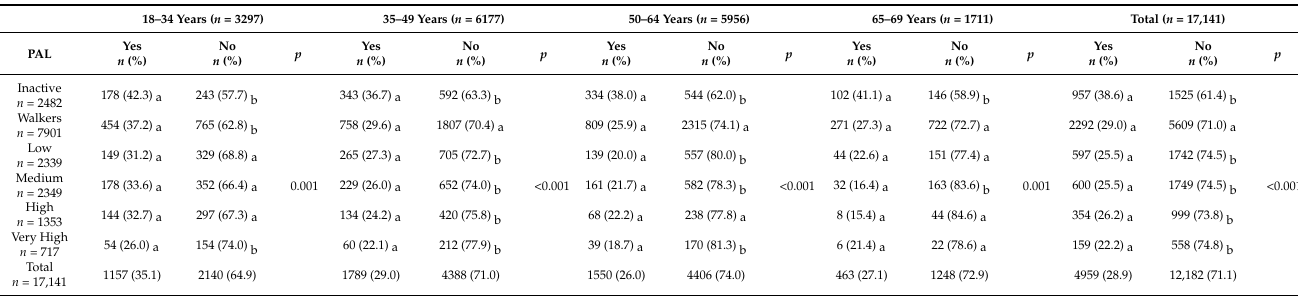
Values presented in absolute and relative frequencies; n : number of participants; % Percentage; PAL (Physical Activity Level); PAI: Physical Activity Index; only considers vigorous and moderate physical activity. Scores between 0 and 67.5; Inactive: PAI = 0; reports not walking at least one day a week for more than 10 min at a time; Walkers PAI = 0; reports walking at least one day a week for more than 10 min at a time; Low: PAI = 1–15;